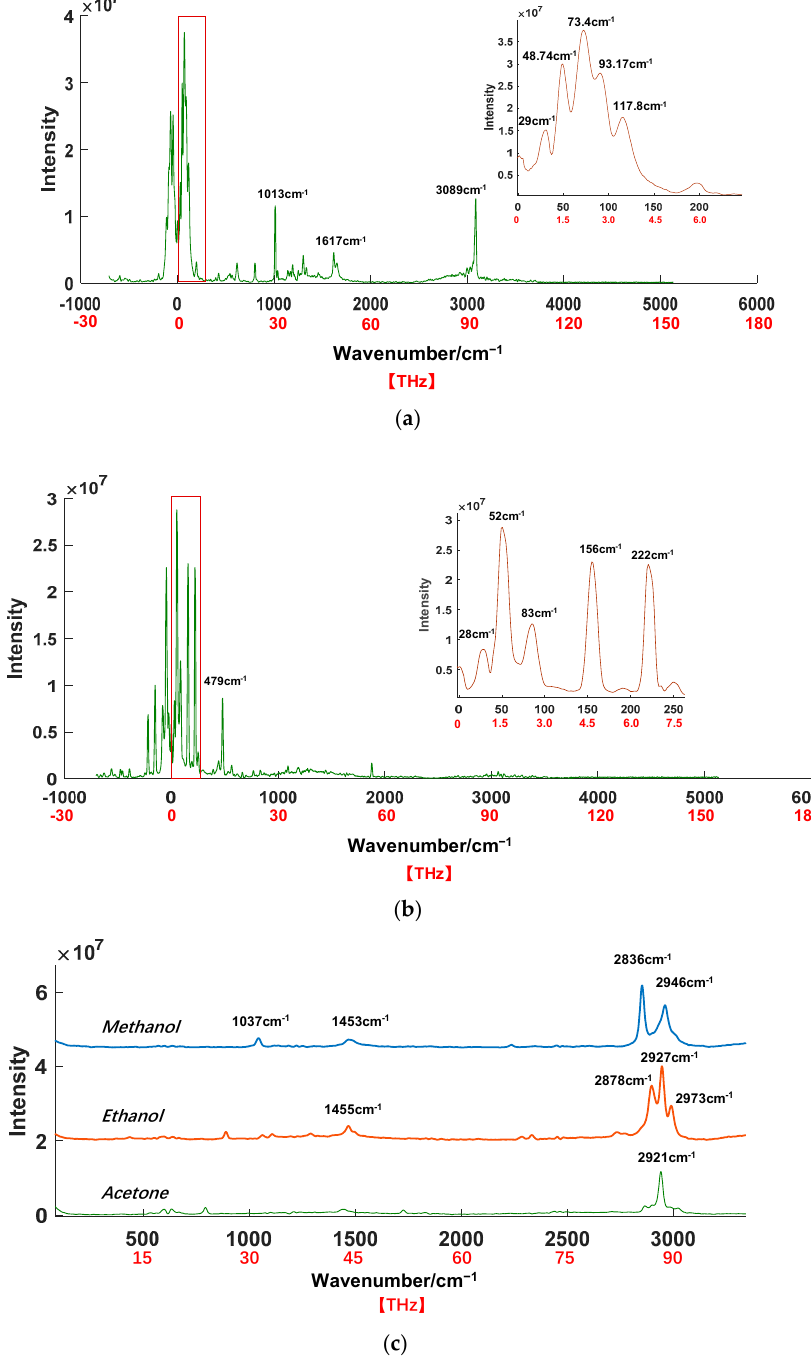
Figure 7. ( a ) Wide band spectrum of benzoic acid; ( b ) wide band spectrogram of sulfur; ( c ) wide band spectra of three organic solutions (methanol, ethanol, and acetone) .